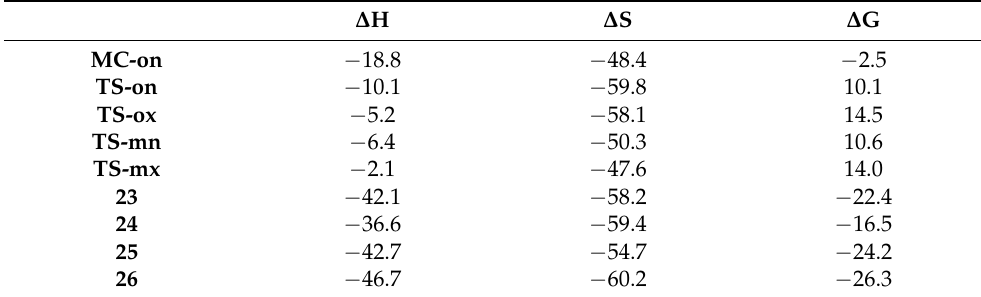
Table 3. ω B97X-D/6-311G(d,p) relative enthalpies ( ∆ H, kcal · mol − 1 ), entropies ( ∆ S, cal · mol − 1 · K − 1 ), and Gibbs free energies ( ∆ G, kcal · mol − 1 ), computed at 65 ◦ C in methanol, of the stationary points involved in the 32CA reaction of AY 21 with ferrocene ethylene 22 . ∆ H ∆ S ∆